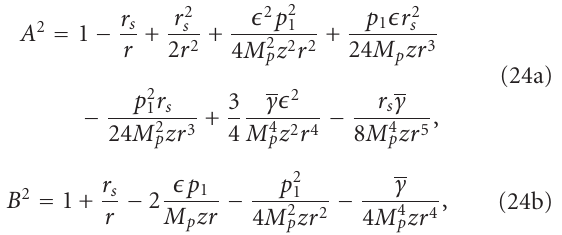
with the scale factor. We ϕ